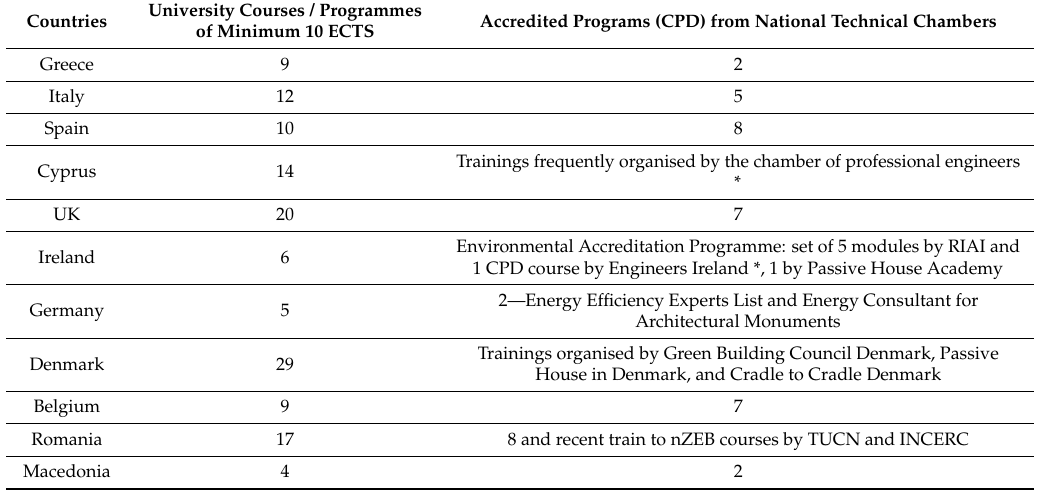
Table 4. Existing Accredited Courses and Programmes related to nZEB, source: [17,27] **. Countries